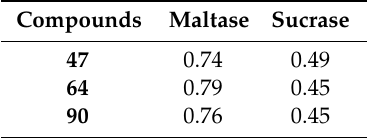
Table 14. IC 50 values for maltase and sucrase inhibition by compounds 47 , 64 and 90 [67]. Compounds Maltase Sucrase